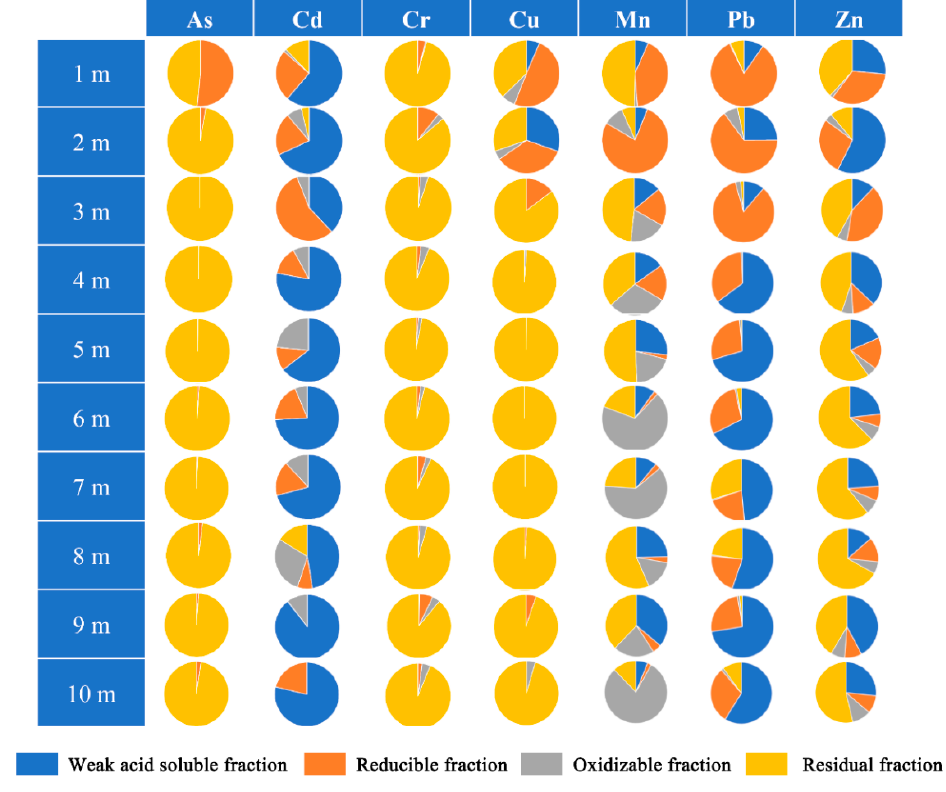
Figure 2. The mean concentration of As, Cd, Cr, Cu, Mn, Pb and Zn in soil vertical profile.